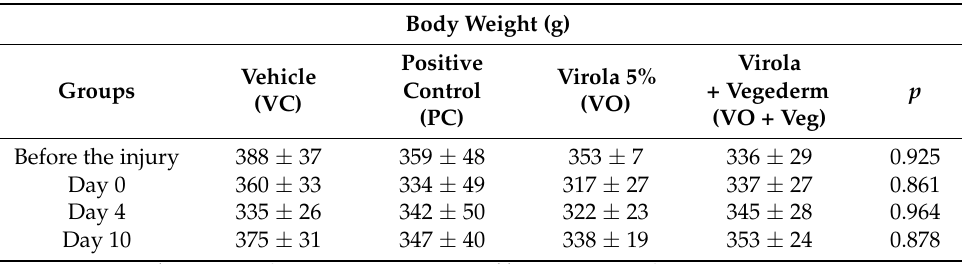
Table 1. Variation in body weight (g) of Wistar rats after treatment with topical VO and other groups for 10 consecutive days.